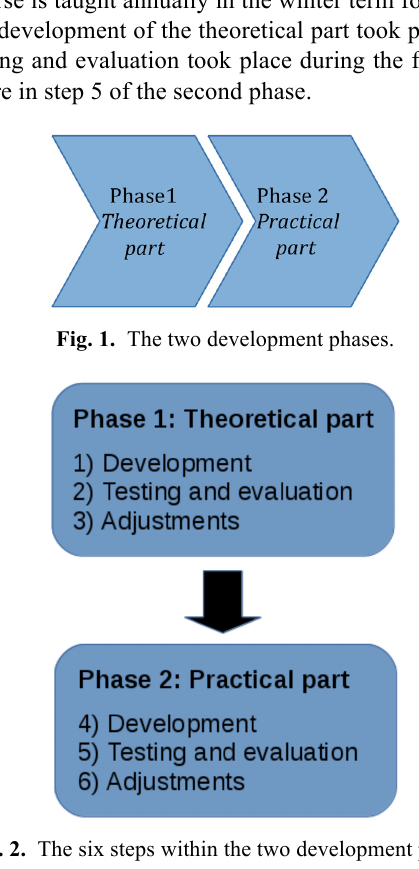
Fig. 2. The six steps within the two development